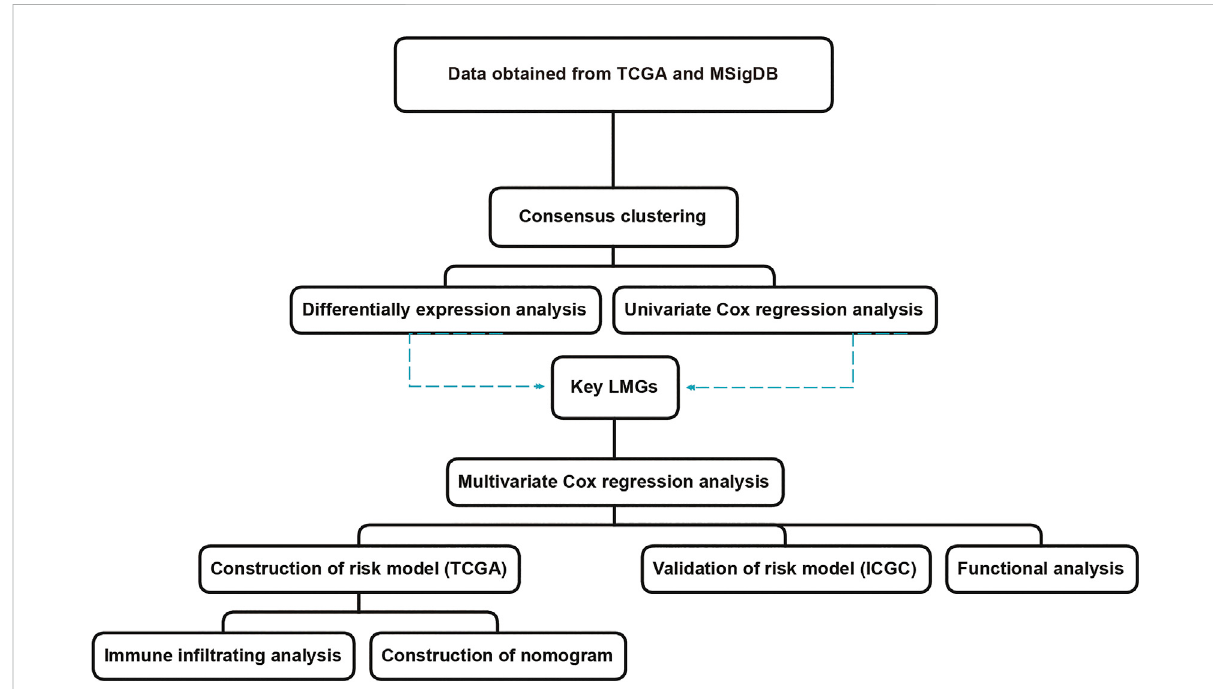
FIGURE 1 The work fl ow of lipid metabolism-related signature identi fi cation. TCGA: The Cancer Genome Atlas. MSigDB: Molecular Signatures Database. ICGC: International Cancer Genome Consortium. LMGs: Lipid metabolism-associated